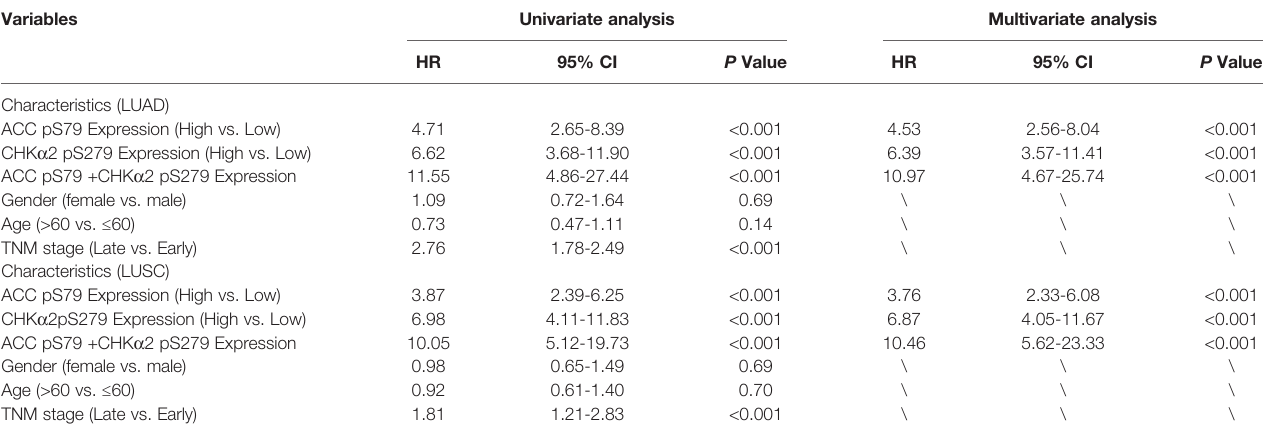
TABLE 3 | Univariate and multivariate Cox regression analyses of risk factors associated with overall survival.